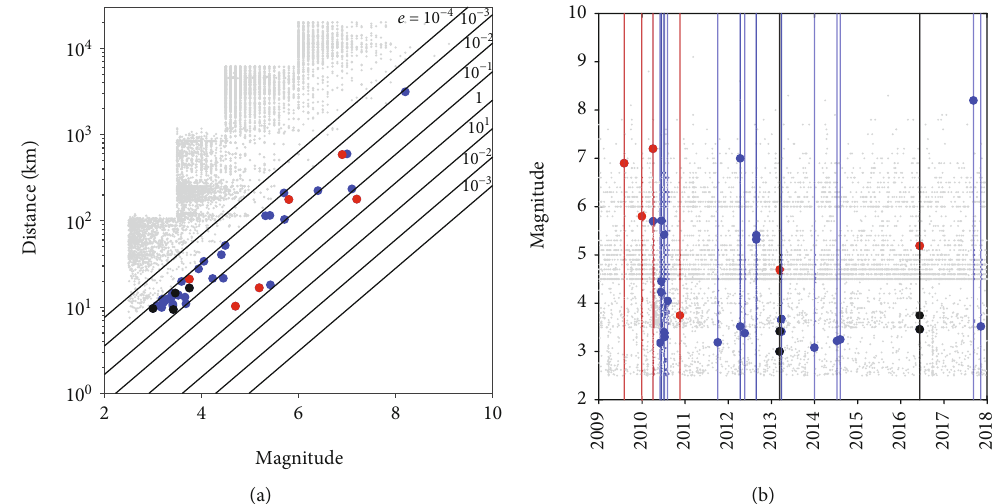
Figure 13: (a) Catalogued earthquakes for B084. Seismic energy density plotted as contours, with all earthquakes larger than 10 -3 J m -3 plotted as larger markers. Red events represent main shocks that caused changes in permeability; black events are aftershocks from these events, while blue events caused no change in permeability. (b) Magnitude of events over time. Red events represent main shocks that caused changes in permeability; black events are aftershocks from these events, while blue events caused no change in